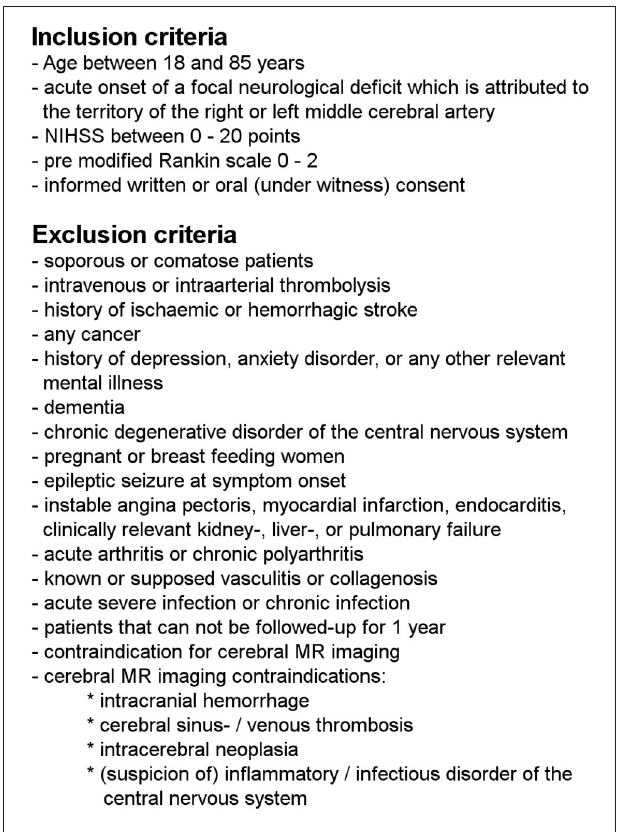
FIGURE 1 | In- and exclusion criteria of the study population in